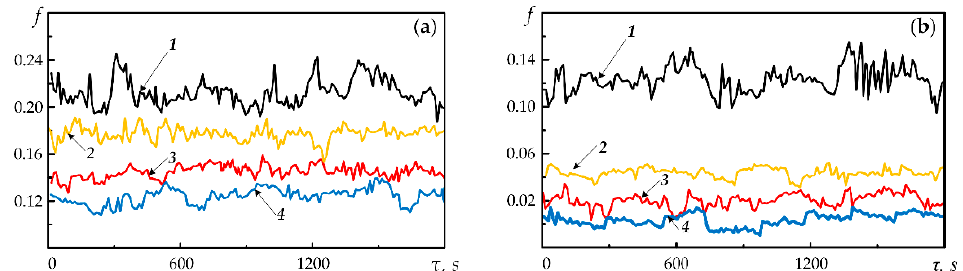
Figure 13. Friction coefficient of titanium Grade 2 in tribo-pairs with 316L stainless steel (a) and UHMWPE (b): in initial state (1), after nitriding at 750 °C (2) and 900 °C (3), and after boriding (4).